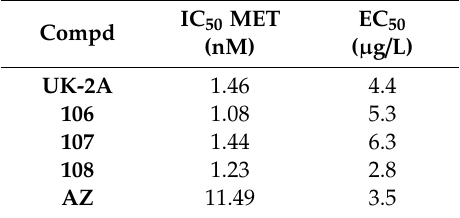
Table 12. Comparative target site and in vitro antifungal activities of UK-2A and representative compounds 106 – 108 from References